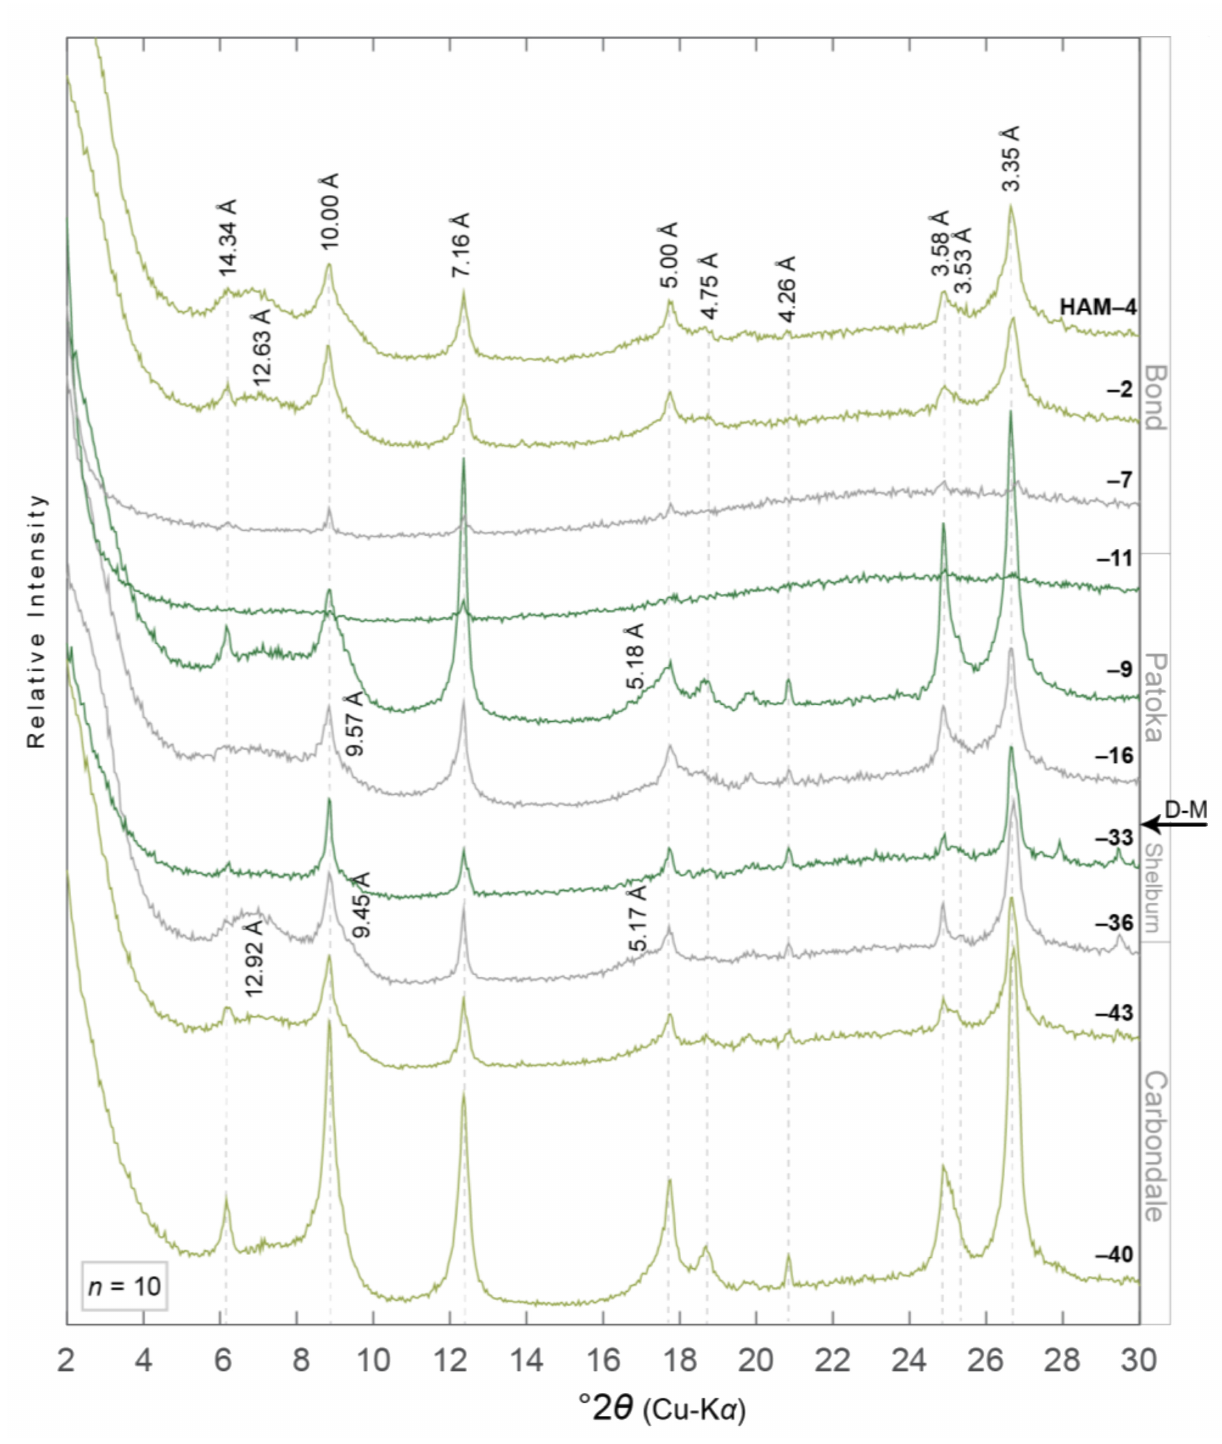
Figure 6. XRD patterns of ethylene glycol saturated oriented aggregates of the <2.0 µ m equivalent spherical diameter clay- sized fraction from paleosols in the American Coal Company Borehole 7510-20 (HAM) core ( n = 10). Diffraction patterns are organized with respect to their relative stratigraphic position, i.e., HAM-40 and HAM-4 are stratigraphically the lowest and highest samples, respectively. D-spacing information for minerals discussed herein are noted vertically and in angstroms (Å). Diffraction patterns are colored to correspond with paleosol type, i.e., grey = gleyed Protosol (Pedotype B [43,44]), dark green = gleyed Vertisol (Pedotype C), and light green = gleyed calcic Vertisol (Pedotype D). Desmoinesian–Missourian boundary. Core location noted in Figure 2. See Tables 1 and 2 for more